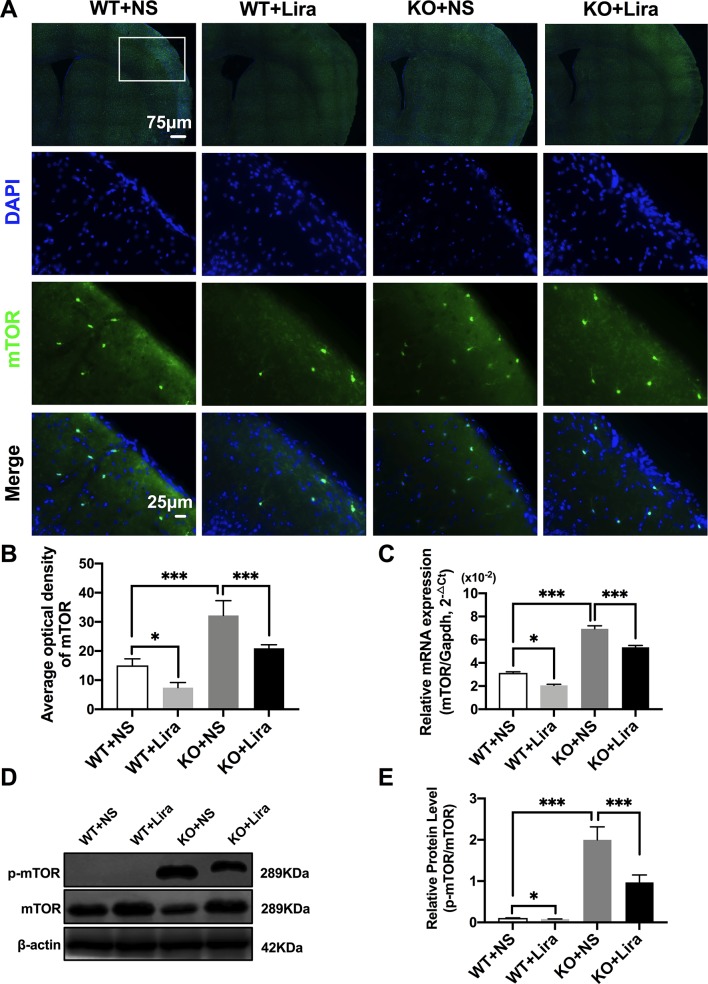
Liraglutide inhibited phosphorylation mTOR hyperactivation in Scn1a KO-induced epileptic mice. (A) Representative images of immunofluorescent staining with mTOR (green), and DAPI (blue) in the ipsilateral side of the cortex of the WT and Scn1a KO mice. Scale bar: 75 μm for the full-scale images and 25 μm for the magnified images. (B) Summary graph of the average optical density of mTOR fluorescent staining measured in images (A) demonstrating a decrease of mTOR in the cortex of Scn1a KO mice after liraglutide administration (N = 24 mice per group; Student’s t-test, P < 0.001). (C) RT-qPCR analysis of the mTOR mRNA expression from brains of wild-type (WT) and Scn1a KO heterozygote (KO) mice (N = 24 mice per group; One-way ANOVA, Student’s t-test). (D) Representative western blotting showing mTOR protein expression in brains of WT and Scn1a KO mice. (E) Summary graph of western blotting analysis demonstrating a significant reduction in the mTOR protein in brains of Scn1a KO as compared to WT mice after liraglutide administration (N = 24 mice per group; Student’s t-test, P < 0.001). The relative expression of SCN1A was normalized to reference controls Gapdh and β-actin in RT-qPCR and Western blotting, respectively. Data were presented as mean ± SD; *, *** represent P < 0.05, and P < 0.001, respectively. All experiments were performed in triplicate. WT, Wild-type; KO, Scn1a Knockout heterozygotes (F1); NS, Normal saline; Lira, Liraglutide.